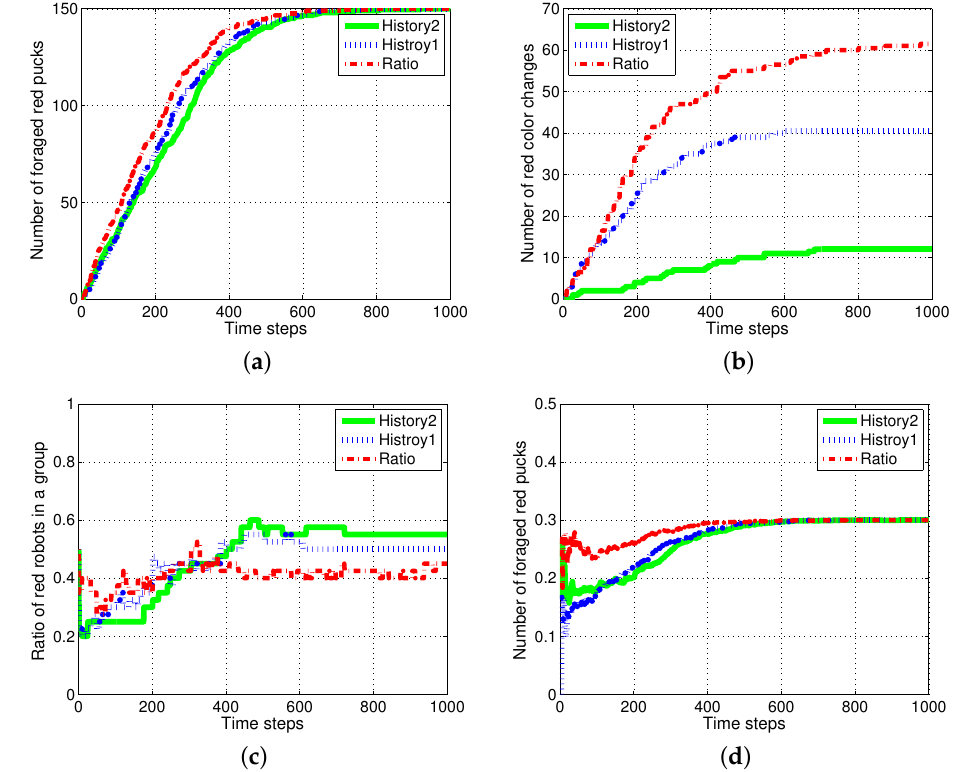
Figure 12. Results of foraging tasks when the foraged pucks were not reproduced. ( a ) Number of foraged red pucks; ( b ) number of task switches in foraging for red pucks; ( c ) ratio of robots foraging for red pucks; ( d ) ratio of foraged red